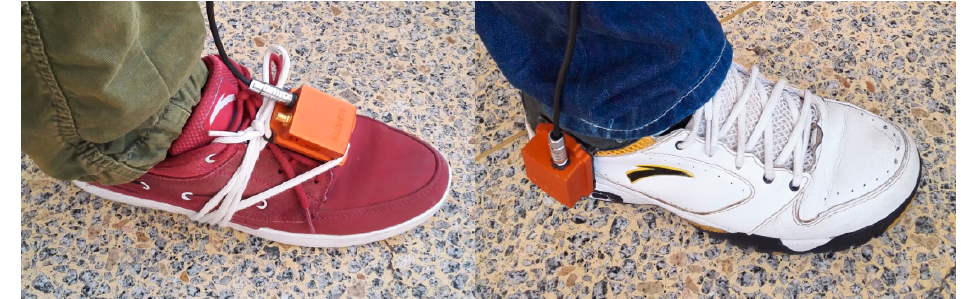
Figure 7. ( Left ) IMU strapped on the front of a shoe; ( Right ) IMU strapped on the rear side of a shoe.